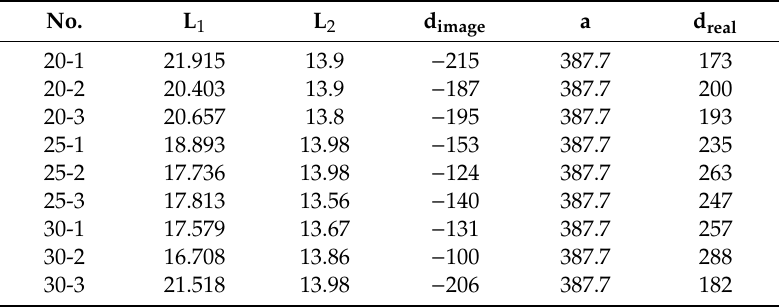
Table 5. Relative distance using a monocular camera (CPNA), [cm].